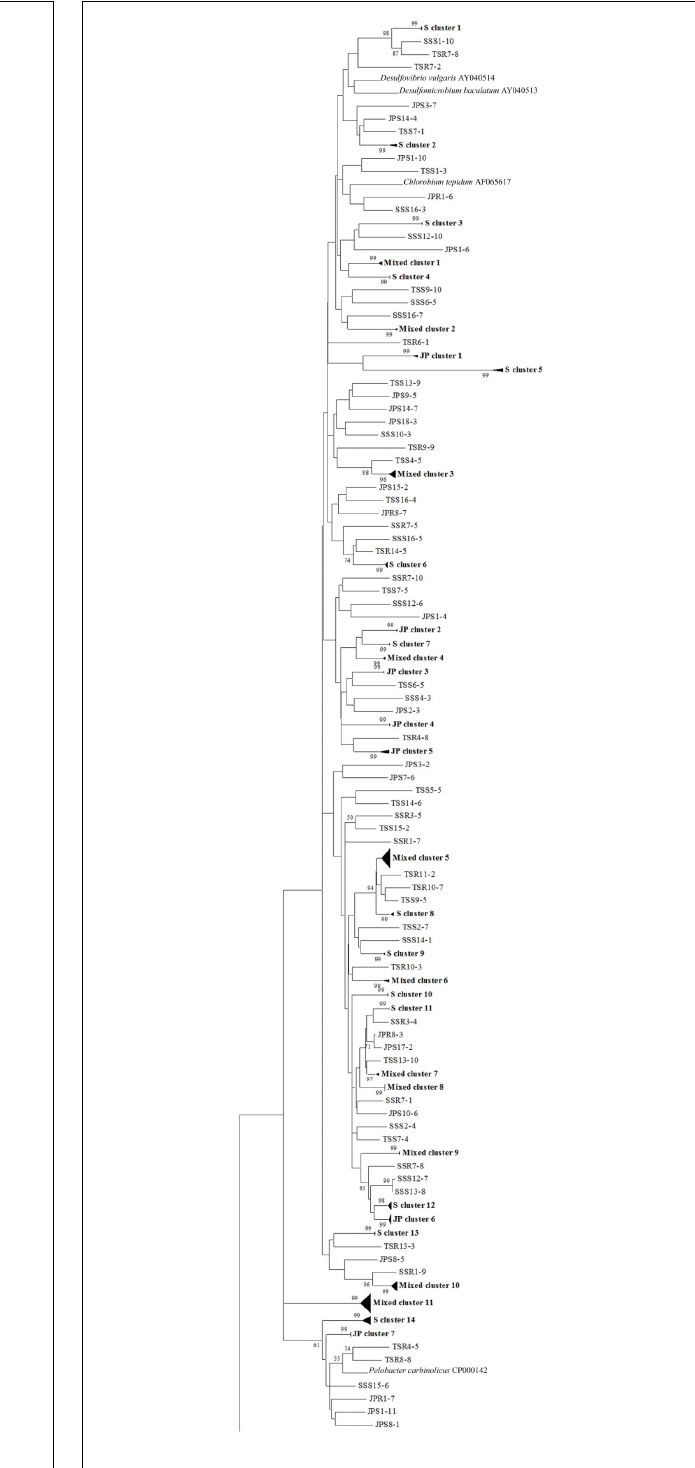
FIGURE 6 | Phylogenetic analysis of all nifH sequences from DGGE bands of rhizoplane (R) and rhizosphere (S) samples from the low marsh plant zones (nucleotide sequences, Neighbor-Joining, Jukes Cantor correction, complete deletion of gaps and missing data, 1000 bootstrap replicates). Boot strap values below 50% are not shown. Abbreviations: JP, J. roemerianus patch; SS, short form S. alterniflora ;TS, tall form S. alterniflora .The phylogram is continued in Figure 7